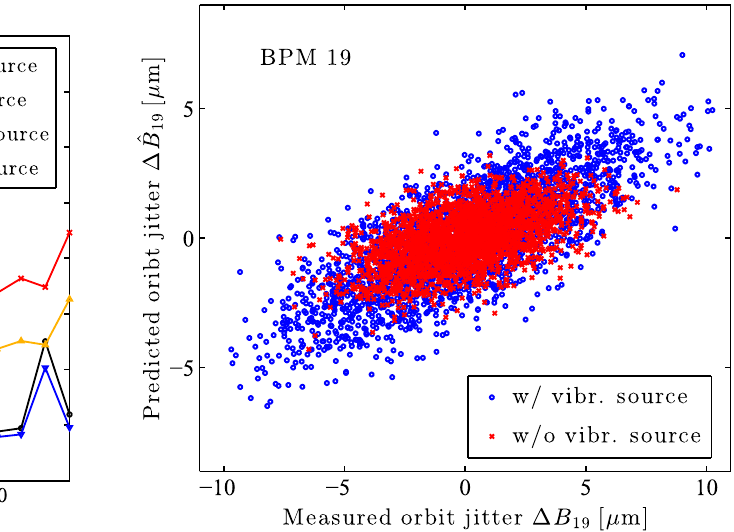
FIG. 15. Predicted and measured orbit jitter at BPM 19, before and after the removal of the vibration